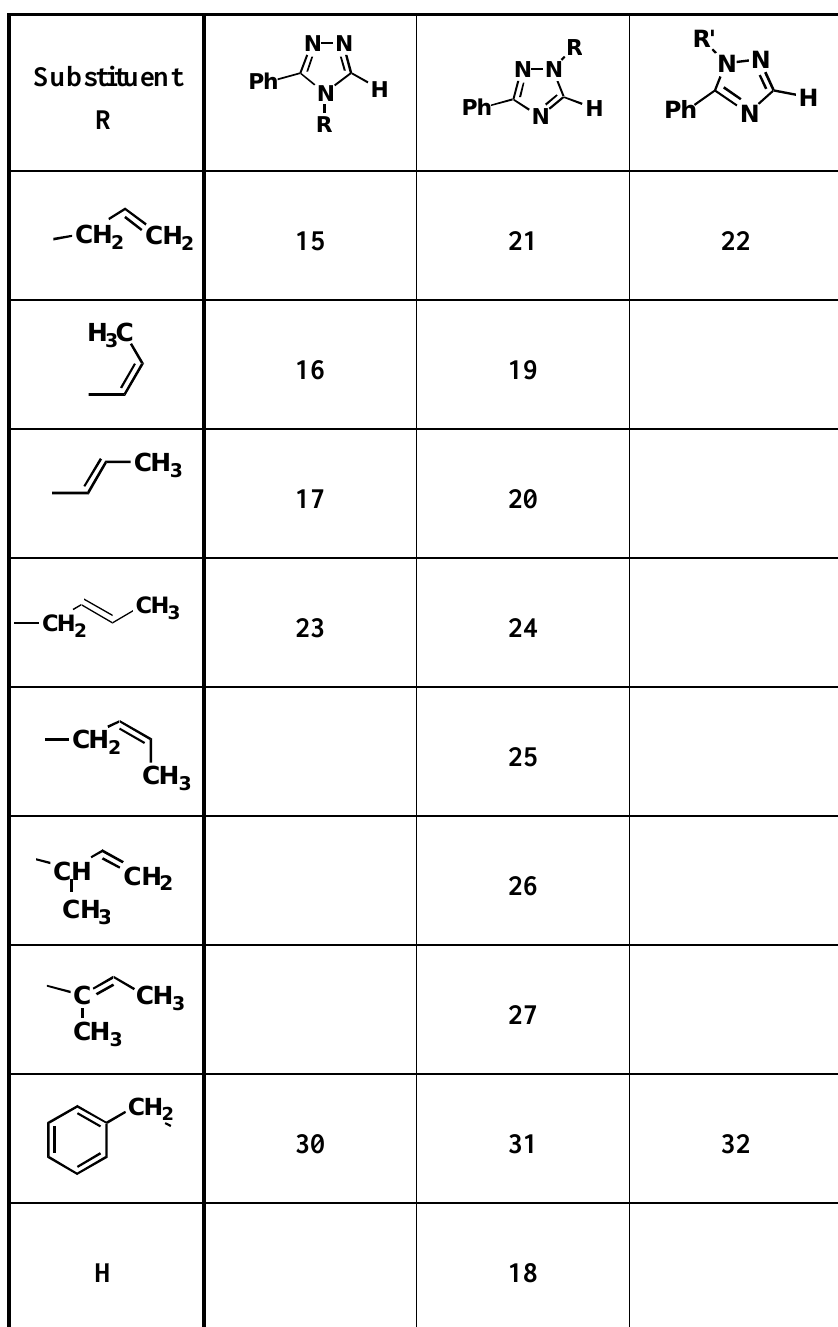
Table 3. The structures of the 3-Phenyl-1H-1,2,4-triazoles thermolyzed at 320 o C and the products